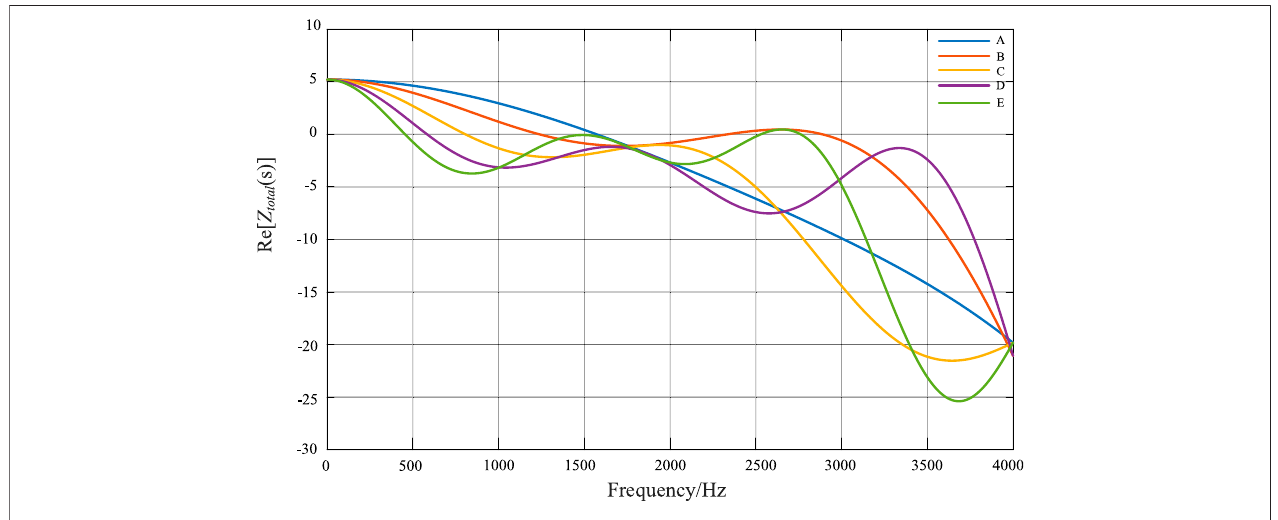
FIGURE 8 | The real part of Z total(s) with different time delays.